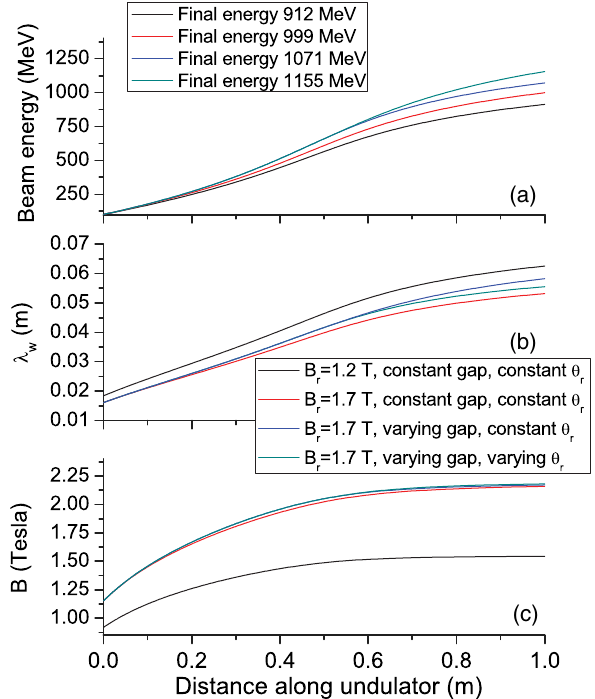
FIG. 3. (a) Resonant energy along the undulator for different cases. (b) Variation of undulator period (cid:1) (c) Variation of magnetic field amplitude B along the